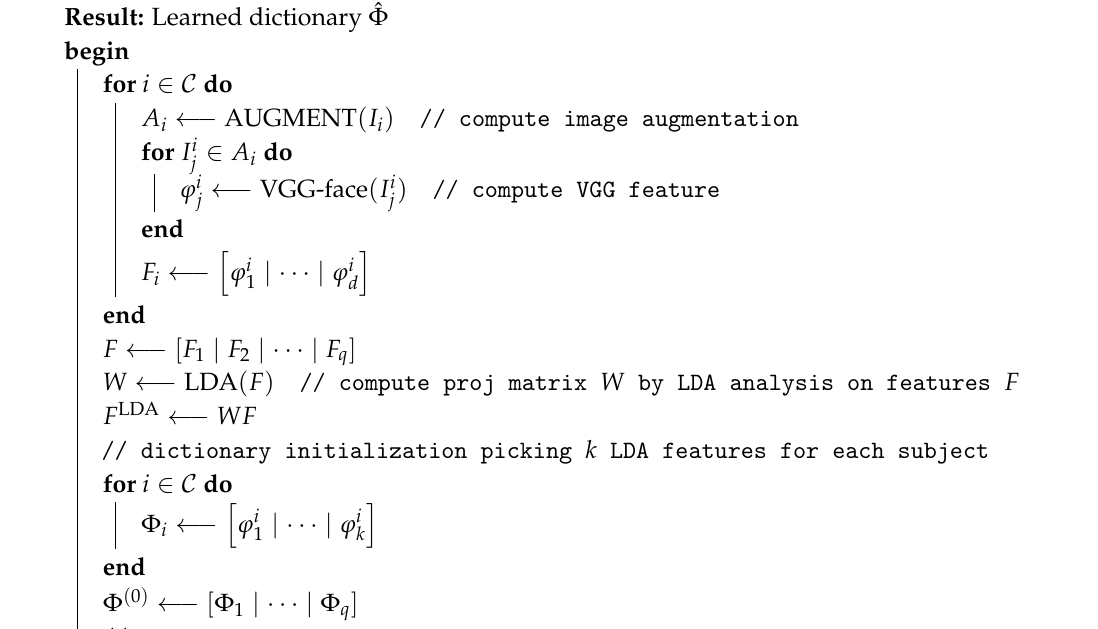
Algorithm 1: SSLD: Learning